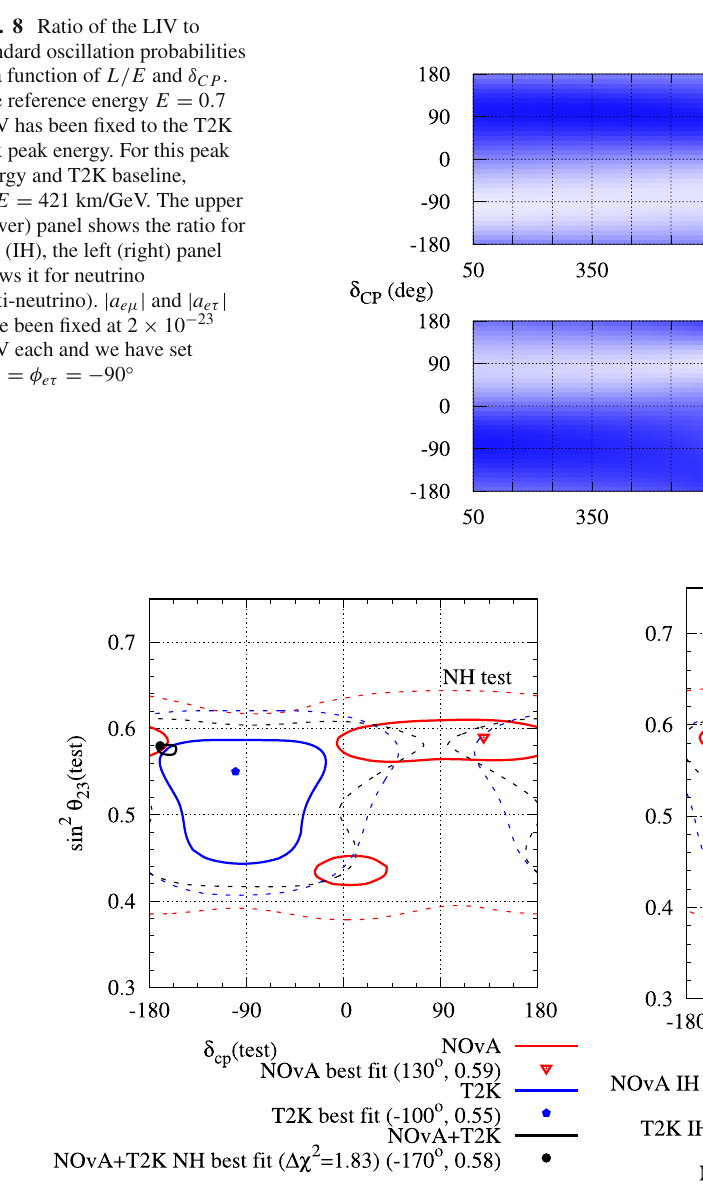
and the black line indicates the combined analysis of both. The solid (dashed) lines indicate the 1 σ (3 σ ) allowed regions. The minimum χ 2 for NO ν A (T2K) with 50 (88) bins is 48.65 (95.85) and it occurs at NH. For the combined analysis, the minimum χ 2 with 138 bins is